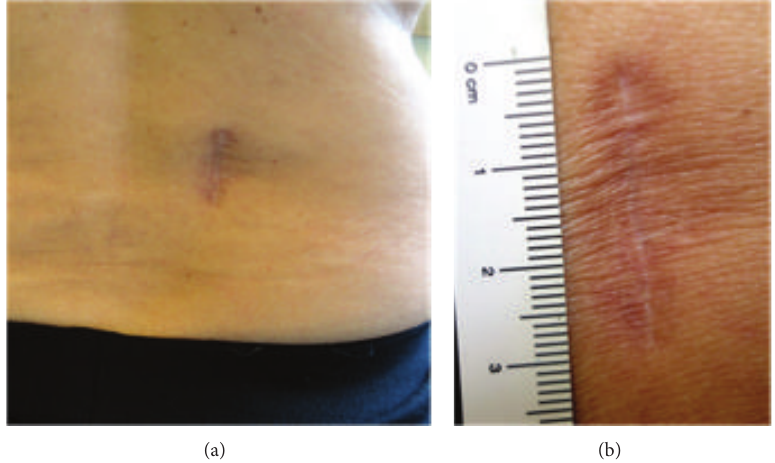
Figure 7: (a) Three cm long right paramedian longitudinal skin incision 4 to 5cm off the midline; (b) final cosmetic